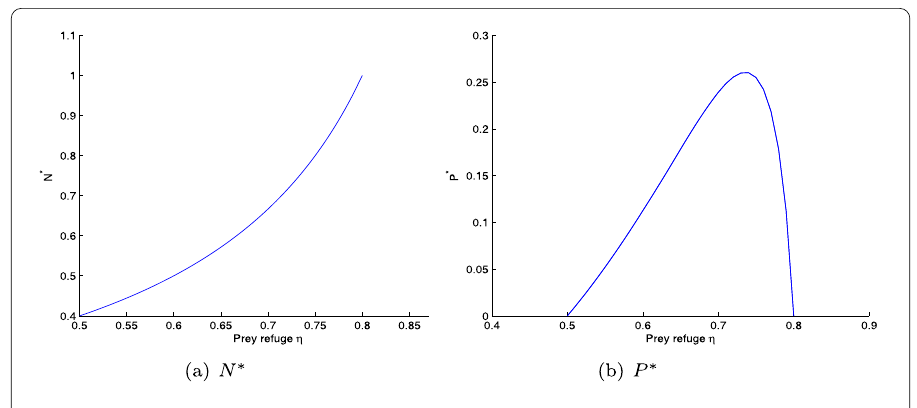
Figure 2 The relation between positive equilibrium E ∗ with prey refuge η